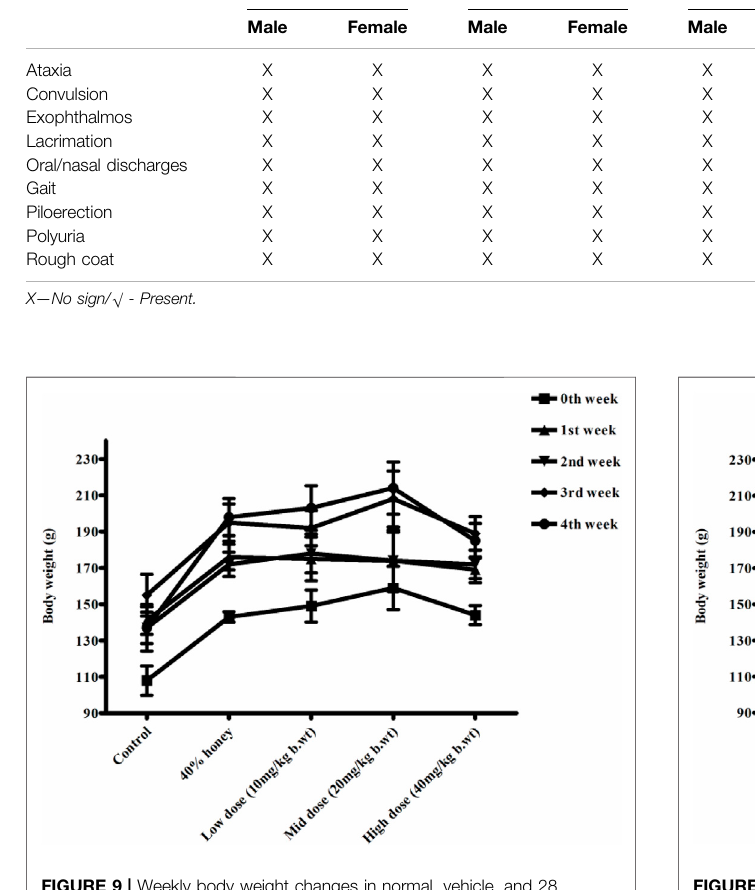
TABLE 1 | Effect of in-house Thamira parpam on clinical signs (Acute and Sub-acute). Clinical